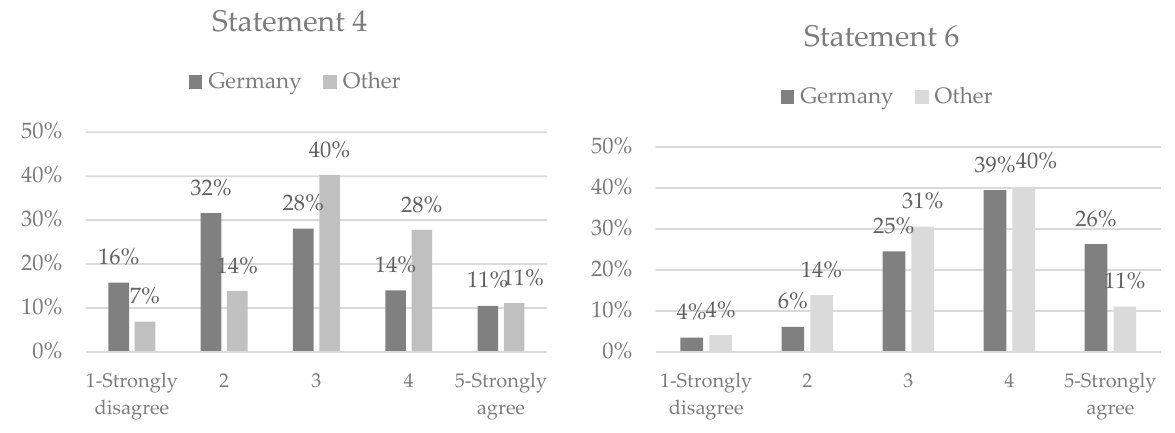
Figure 9. Statements on technology capability ( left ) and trust in the system ( right ).